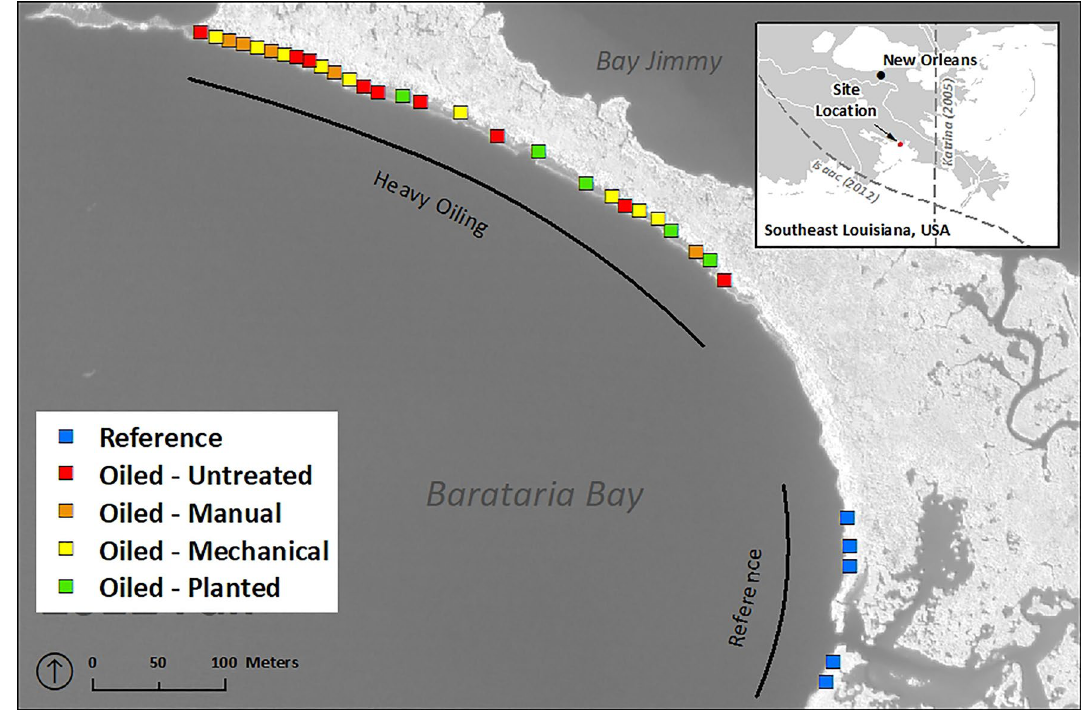
Figure 1. Field experiment map with study sites by marsh oiling/treatment class, including reference. The study area is salt marsh dominated by Spartina alterniflora , located on Barataria Bay, part of the Mississippi River Delta, Southeast Louisiana, USA. Inset map includes tracks for Hurricane Katrina (2005, east of study site) and Hurricane Isaac (2012, south and west of study site). Figure generated by the authors for this research using ArcGIS v10.8.1 (https:// www. esri. com/ en- us/ arcgis/ produ cts/ arcgis- deskt op/ overv